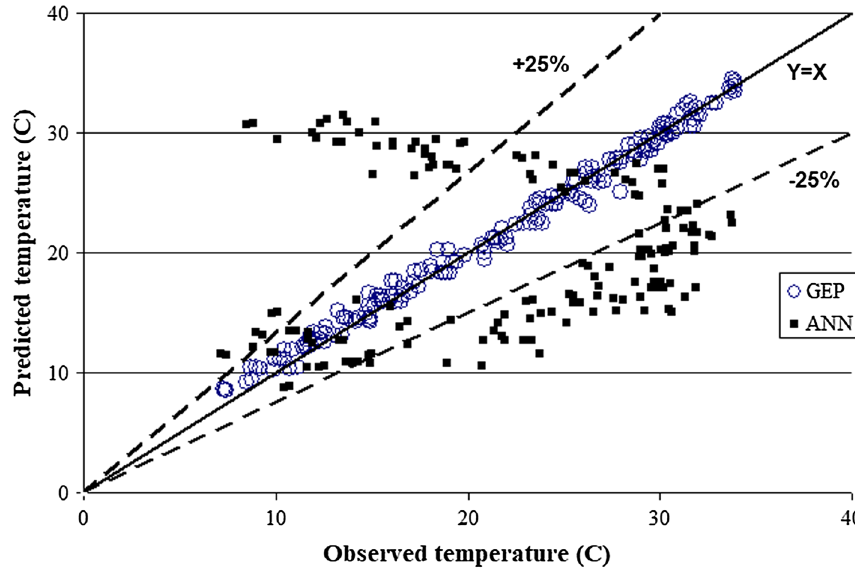
Fig. 4 Comparison of results obtained from ANN and GEP